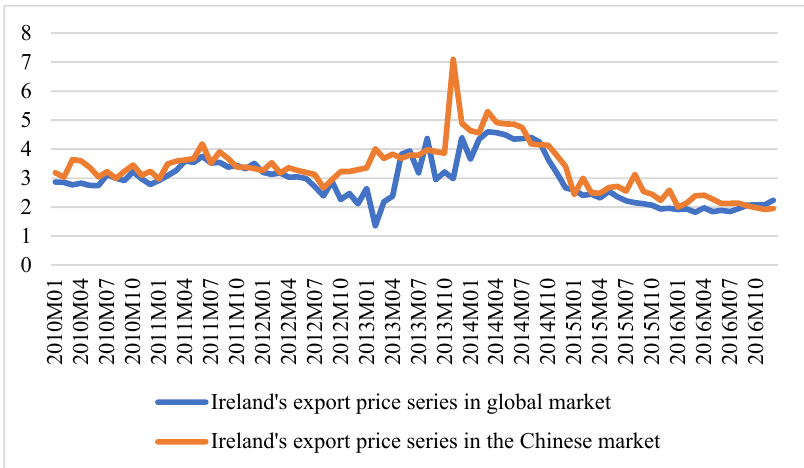
Figure 1. Monthly SMP export prices for Ireland to the Chinese market and globally between January 2010 and December 2016.